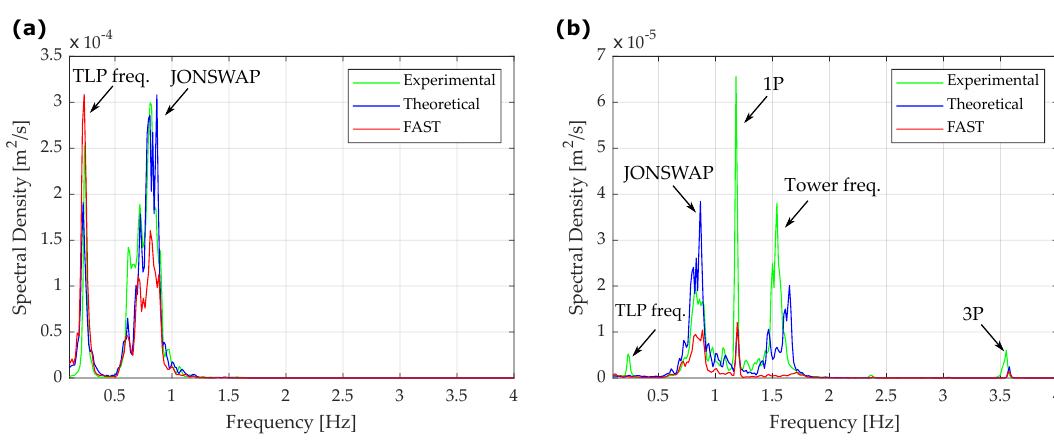
Figure 14. The PSD of the FOWT displacement when affected by a JONSWAP spectrum as in Figure 8 and a mean wind speed of 7 m/s. ( a ) The PSD of the displacement of the TLP in surge. ( b ) The PSD of the displacement of the tower top in